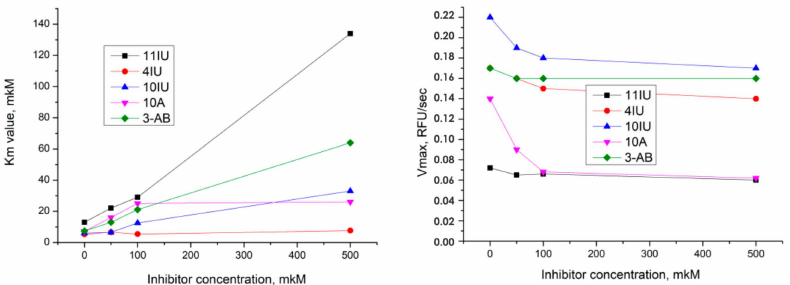
Figure 3. Graphs of Km (left) and Vmax (right) values versus inhibitor concentration. 3-AB , a commercially-available PARP-1 inhibitor [75], was used as a positive